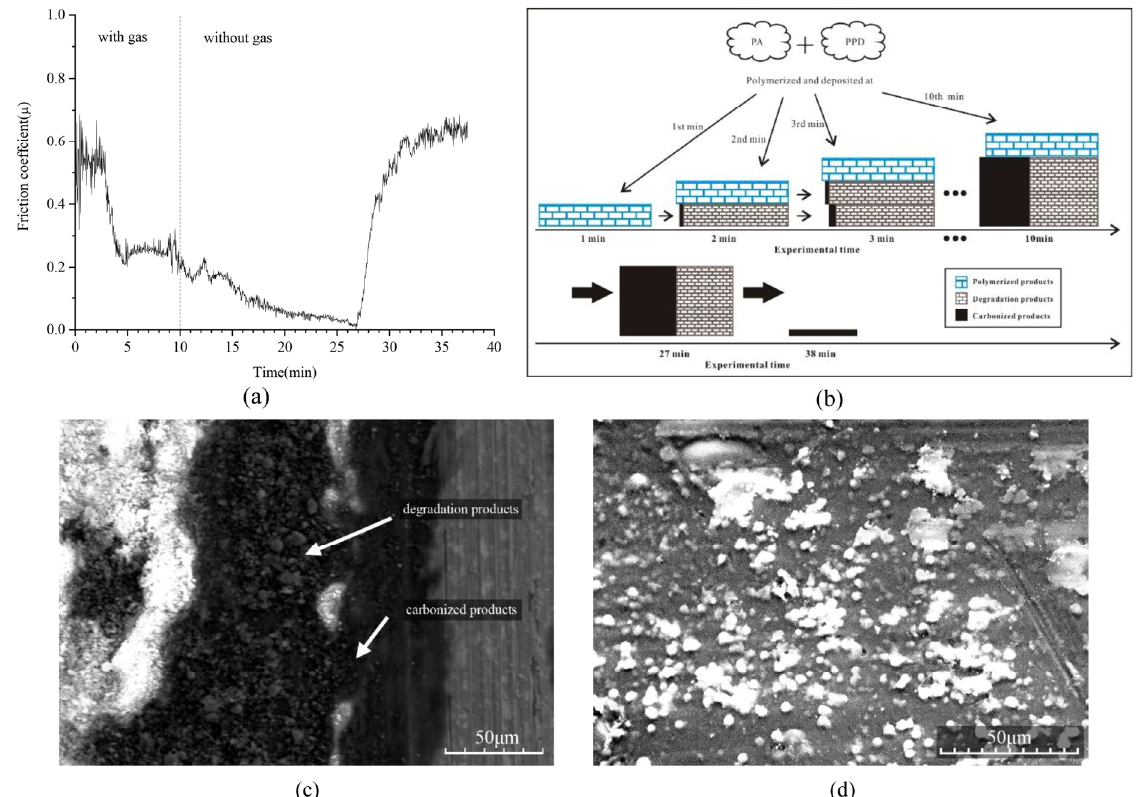
Fig. 45 (a) Coefficient of friction curve for test PA+PPD-38; (b) change in composition of the solid lubricant film during the test; (c) SEM of the steel disc at 27 min; and (d) SEM of the steel ball at 27 min [802]. Reproduced with permission from Ref. [802], © Society of Tribologists and Lubrication Engineers,